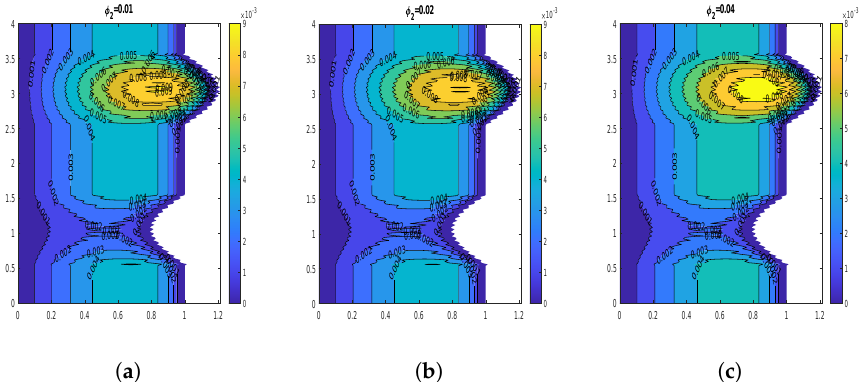
Figure 11. Blood flow patterns for volume fraction of Al 2 O 3 -nanoparticles ( a ) φ 2 = 0.01, ( b ) φ 2 = 0.02, ( c ) φ 2 = 0.04.